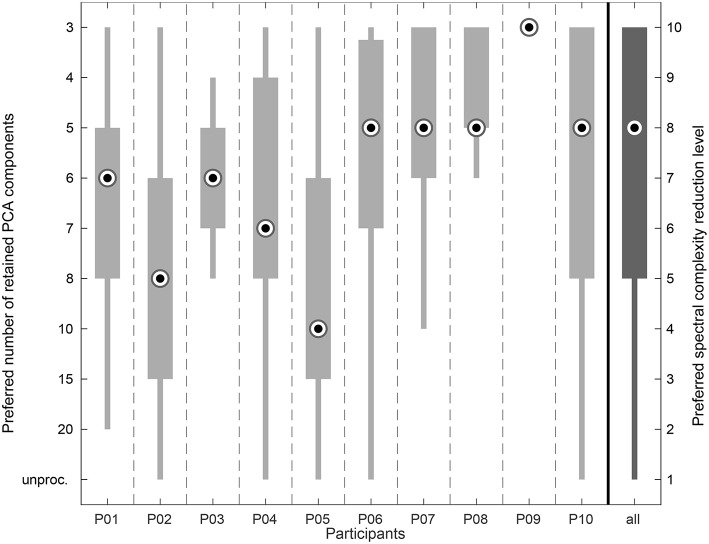
Box plot showing the listening experiment results accumulated over all sessions per participant. The very right column shows the overall distribution of the preference ratings.